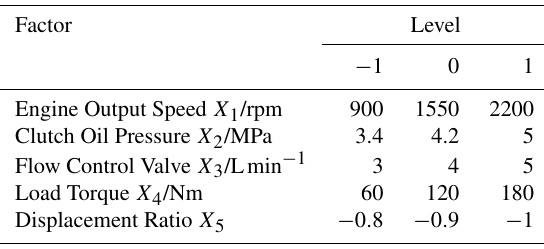
Table 4. Test factor level coding